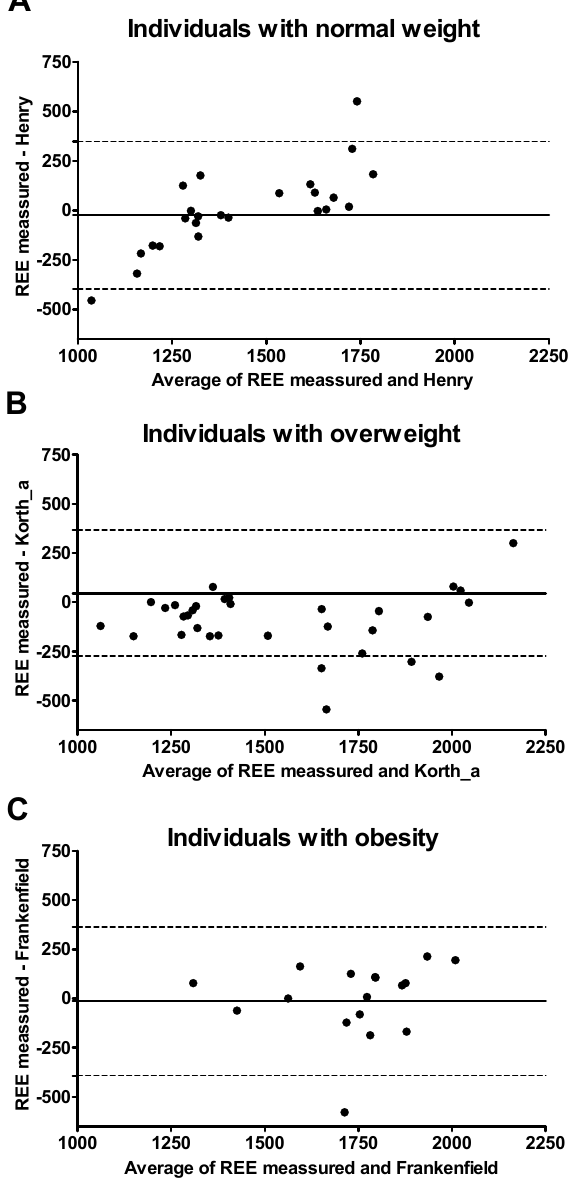
Figure 4. Bland–Altman plots for selected resting energy expenditure (REE) predictive equations. The solid lines represent the mean difference (BIAS) between predicted and measured REE. The upper and lower dashed lines represent the 95% limits of agreement; “_a” refers to predictive equations which required only anthropometric parameters to calculate REE, and “_ht” refers to predictive equations which are proposed by the same author and include height.